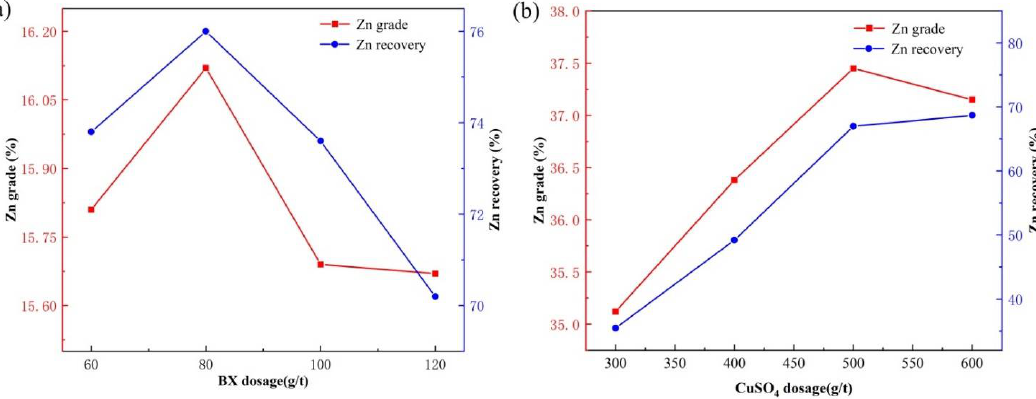
Figure 7. Effects of BX ( a ) and CuSO 4 ( b ) dosages on zinc flotation.